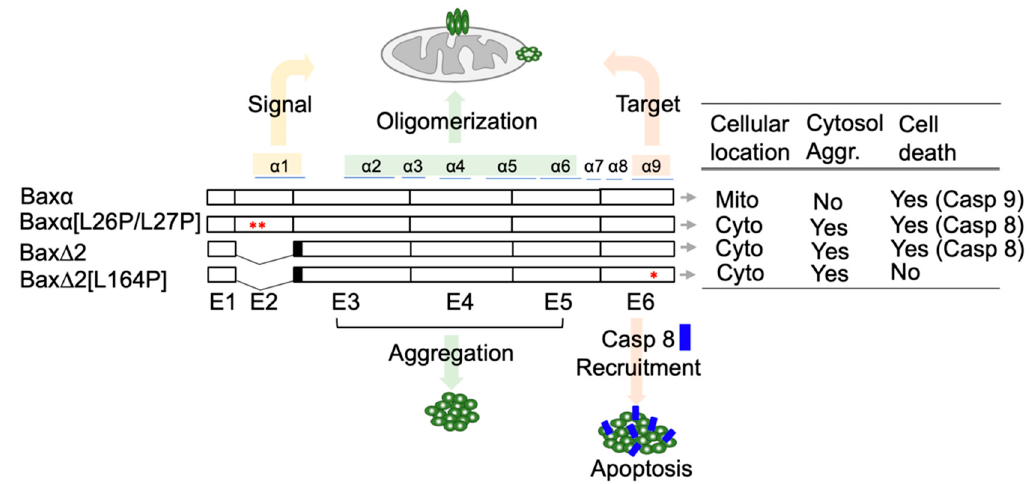
Figure 1. An overview of characteristics of Bax variants. Cellular behaviors of Bax variants. Bax exons are labeled as E1 to E6. The corresponding helices are labeled on the top. The solid black boxes on Bax ∆ 2 and Bax ∆ 2[L164P] indicate the region coding for frameshifted peptide sequences. * indicates the position of mutations, which are adjacent to one another in Bax α [L26P / L27PP]. Mito, mitochondria; Cyto, cytosol; Aggr, aggregation; Casp,